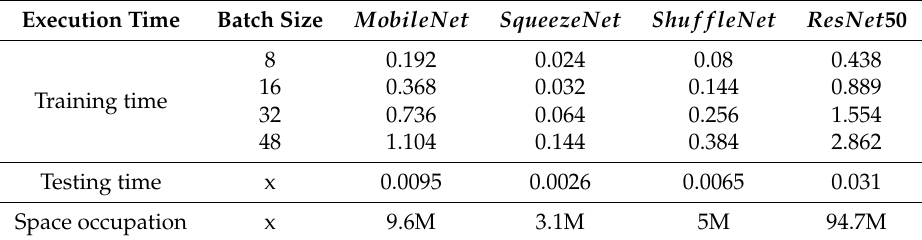
Table 6. Execution time (seconds).